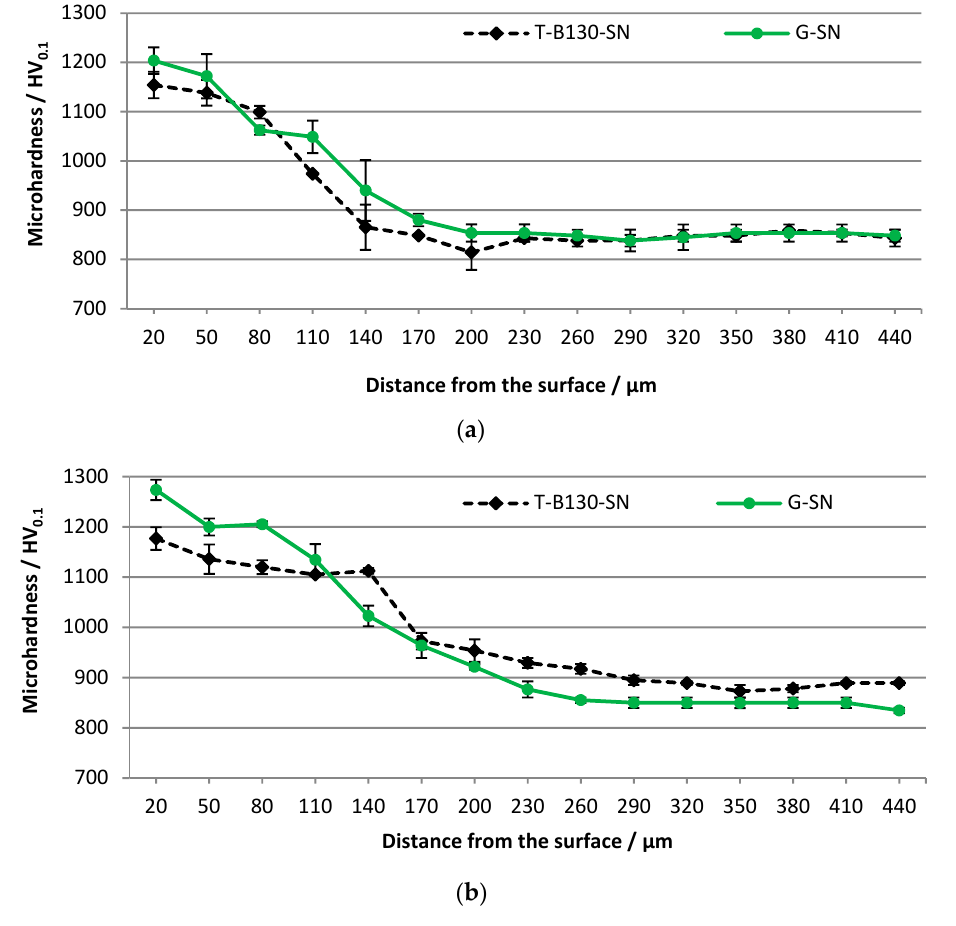
Figure 8. Distribution of microhardness as a function of depth away from the G-SN and T-B130-SN